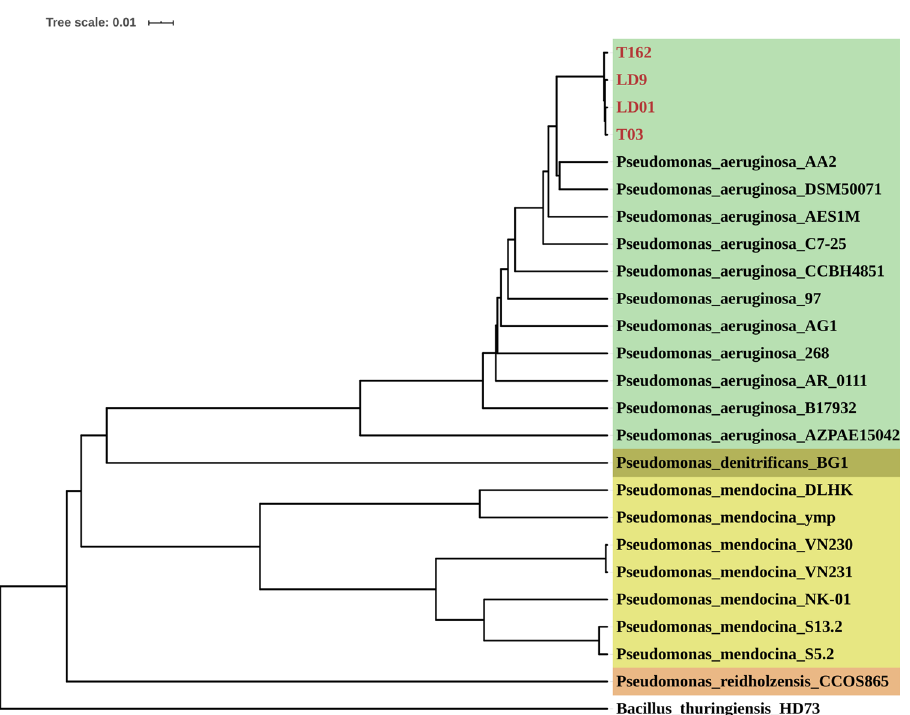
Figure 6. Phylogenetic analysis of four Pseudomonas strains (LD01, LD9, T03, and T162). This tree is constructed based on the whole genome of each strain. Different label background colors represent different clades at the species level. Bt strain Bacillus_thuringiensis_HD73 is used as the